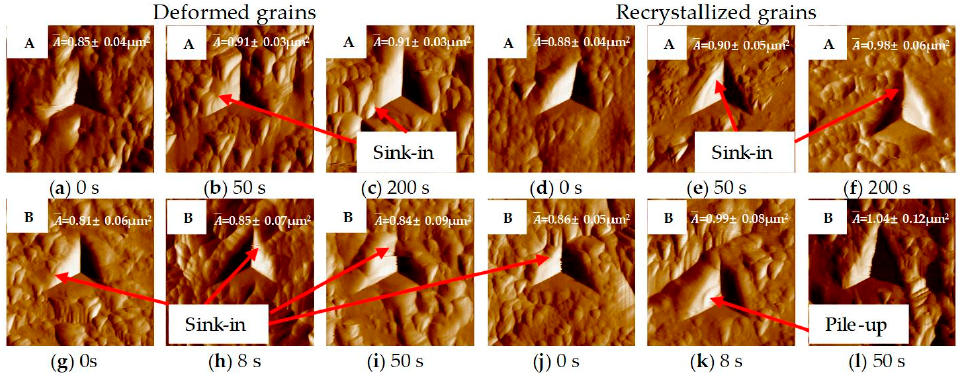
Figure 10. The SPM images of indentation morphology on the deformed grains and recrystallized grains corresponding to: ( a – f ) sample A at the holding time of 0 s to 600 s; ( g – l ) sample B at the holding time of 0 s to 50 s. Data points correspond to average values from 16 measurements for each indentation, and absolute errors correspond to one standard deviation about the mean values.